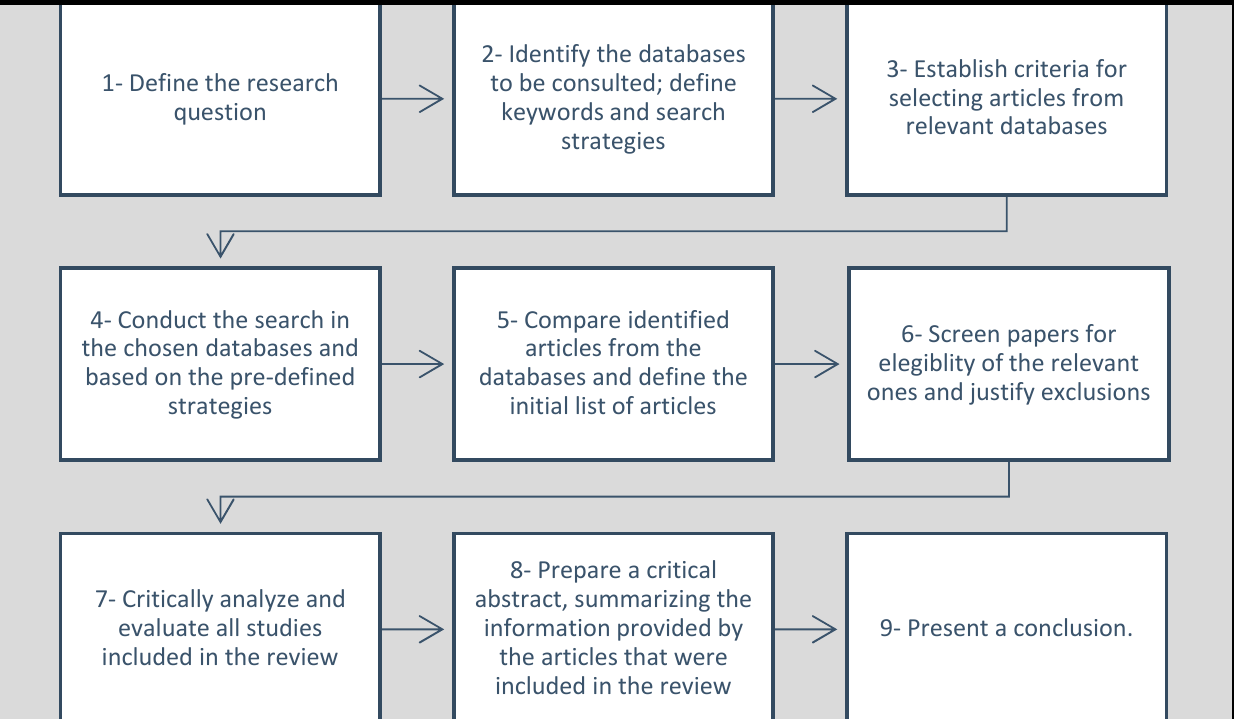
Figure 1. Methodological follow-up of the research..